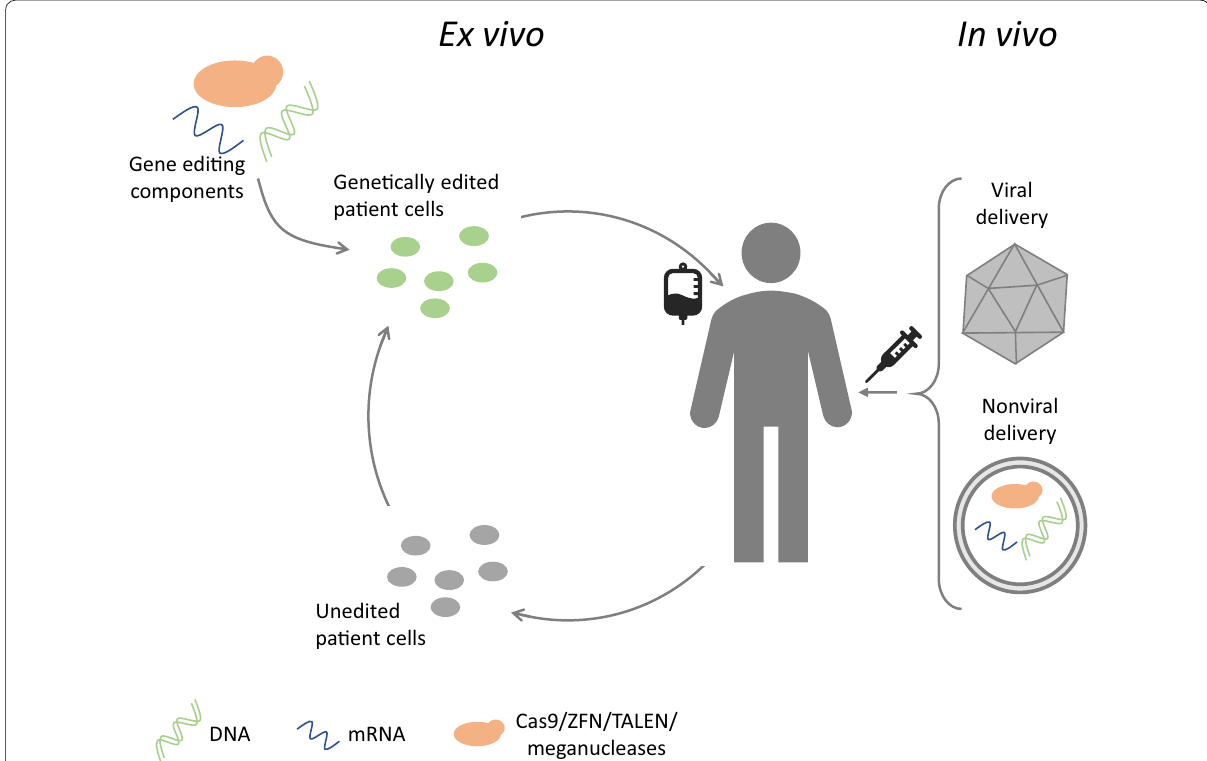
Fig. 1 Ex vivo vs. in vivo gene editing. During ex vivo gene editing, the patient’s cells are removed from the body, genetically modified using gene editing components and then transferred back into the patient’s body. Alternatively, e.g. for allogeneic CAR T cell therapies, cells from healthy donors are genetically modified and then transferred into the patient. For in vivo gene editing, gene editing components are delivered directly to the patient’s cells using either viral or nonviral delivery